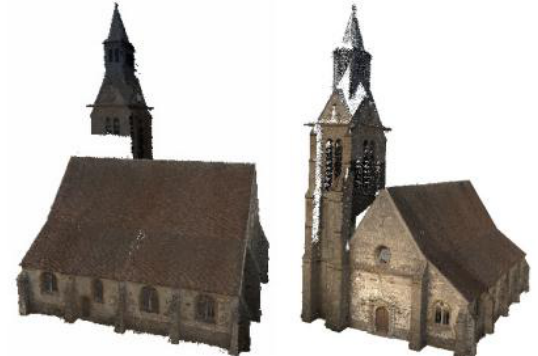
Figure 3: Superposition of point cloud of all master images